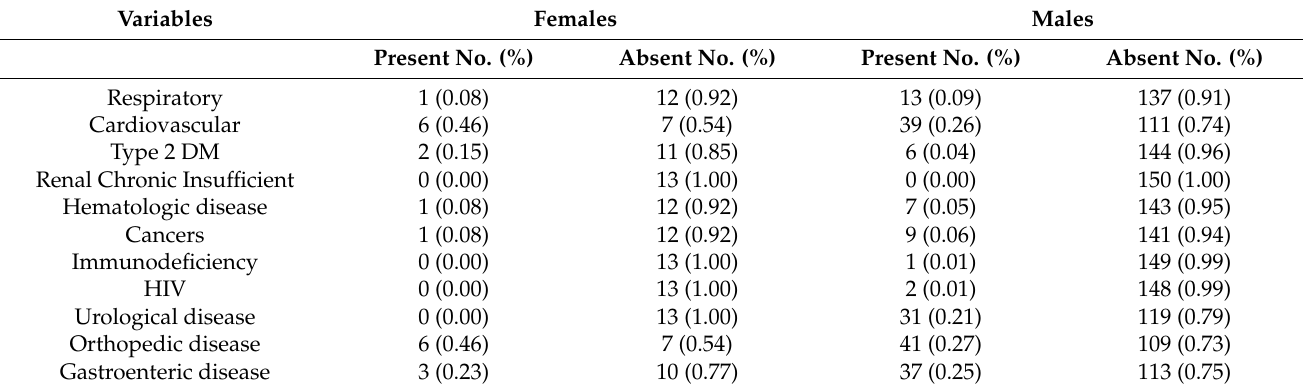
Table 2. Distribution of comorbidity frequency of inmates according to gender: L’Aquila.